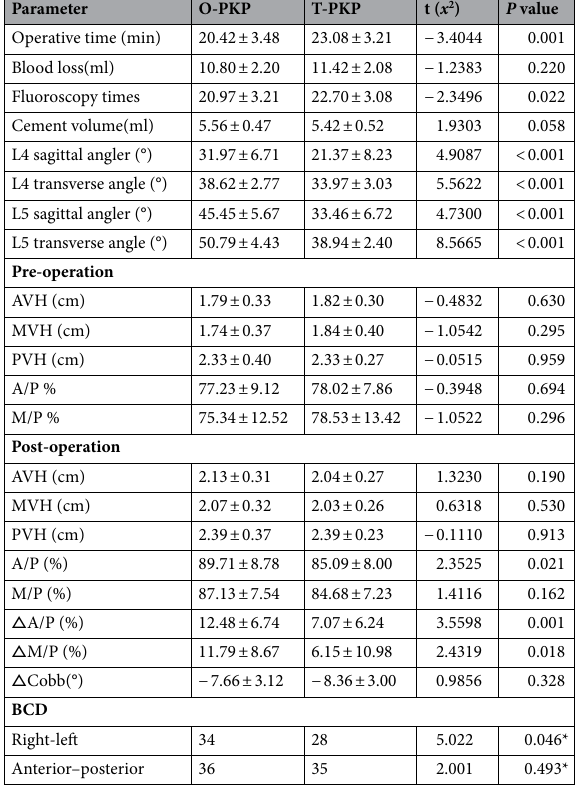
Table 4. Comparisons of clinical and radiographic parameters between groups. A/P, anterior vertebral height / posterior vertebral height × 100%; M/P, middle vertebral height /posterior vertebral height × 100%; △ A/P = postoperative A/P—preoperative A/P; △ M/P = postoperative M/P—preoperative M/P; △ Cobb = postoperative Cobb—preoperative Cobb; BCD, bone cement distribution. * With theoretical cases less than 5 in a cell, Fisher’s exact test method was